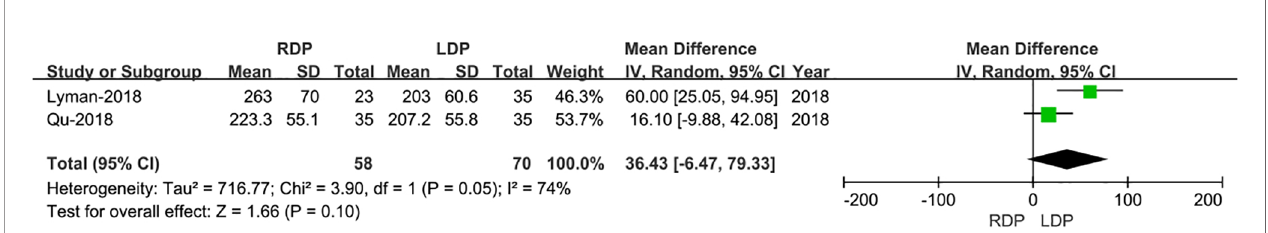
FIGURE 2 | Forest plot of comparison of RDP versus LDP for operative time.